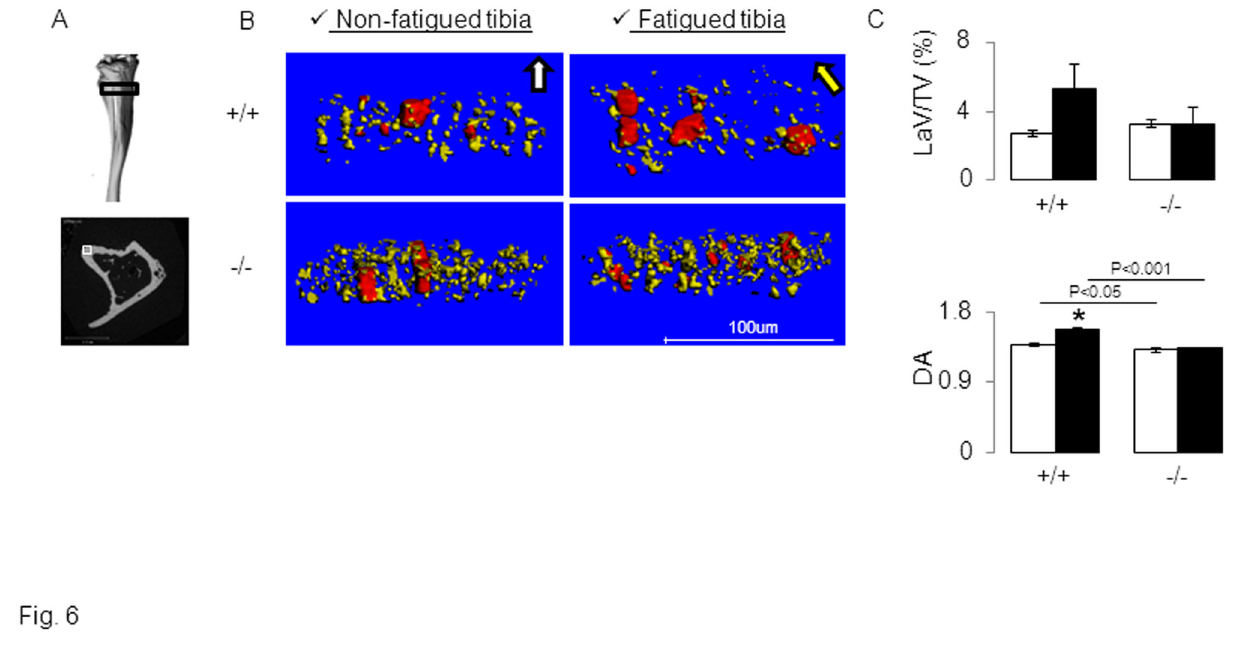
Figure 6. Effects of fatigue loading on the orientation of osteocyte lacunae in Postn -/- vs Postn +/+ mice. 3D reconstructions of osteocytic lacunae were obtained by high resolution-computed tomography scans. (A) Upper panel: The black box illustrates the region of interest, 30 slices from 1.8mm under the proximal growth plate, in which a small cortical region located in the postero- lateral surface of the tibia (Lower panel, white box) was eventually selected for 3D reconstructions. (B) 3 D reconstructions of the canal network (red tubes corresponding to blood vessels or real pores) and osteocyte lacunae (yellow ellipsoids) show the alignment of osteocyte lacunae parallel to the principal direction of mechanical loading in tibia of Postn +/+ mice. In contrast, Postn -/- do not present oriented osteocyte lacunae either in the non-fatigued or fatigued tibia. (C) Lacunae volume on tissue volume (LaV/TV) and Degree of anisotropy (DA). * p<0.05 vs non-fatigued tibia. Bars show mean (± sem), black bars: fatigued tibia, white bars: non-fatigued